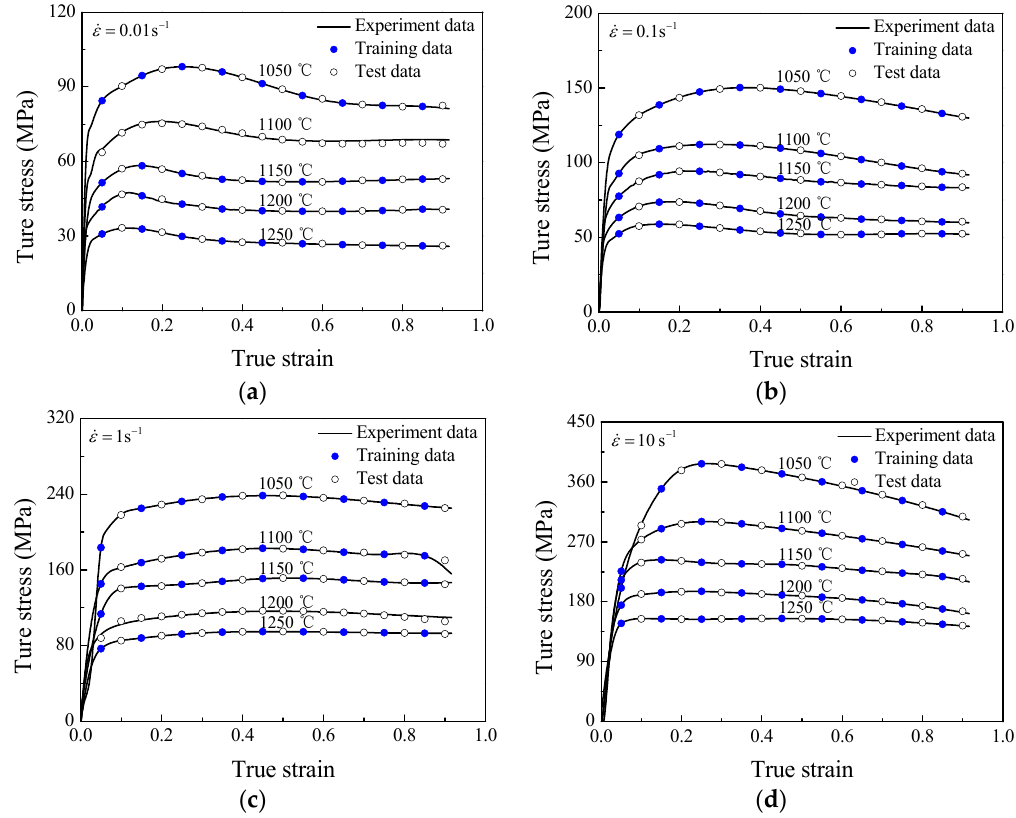
Figure 3. The comparison of the BP-ANN prediction with experimental values at different temperatures and strain rates ( a ) 0.01 s − 1 ; ( b ) 0.1 s − 1 ; ( c ) 1 s − 1 ; ( d ) 10 s − 1 .